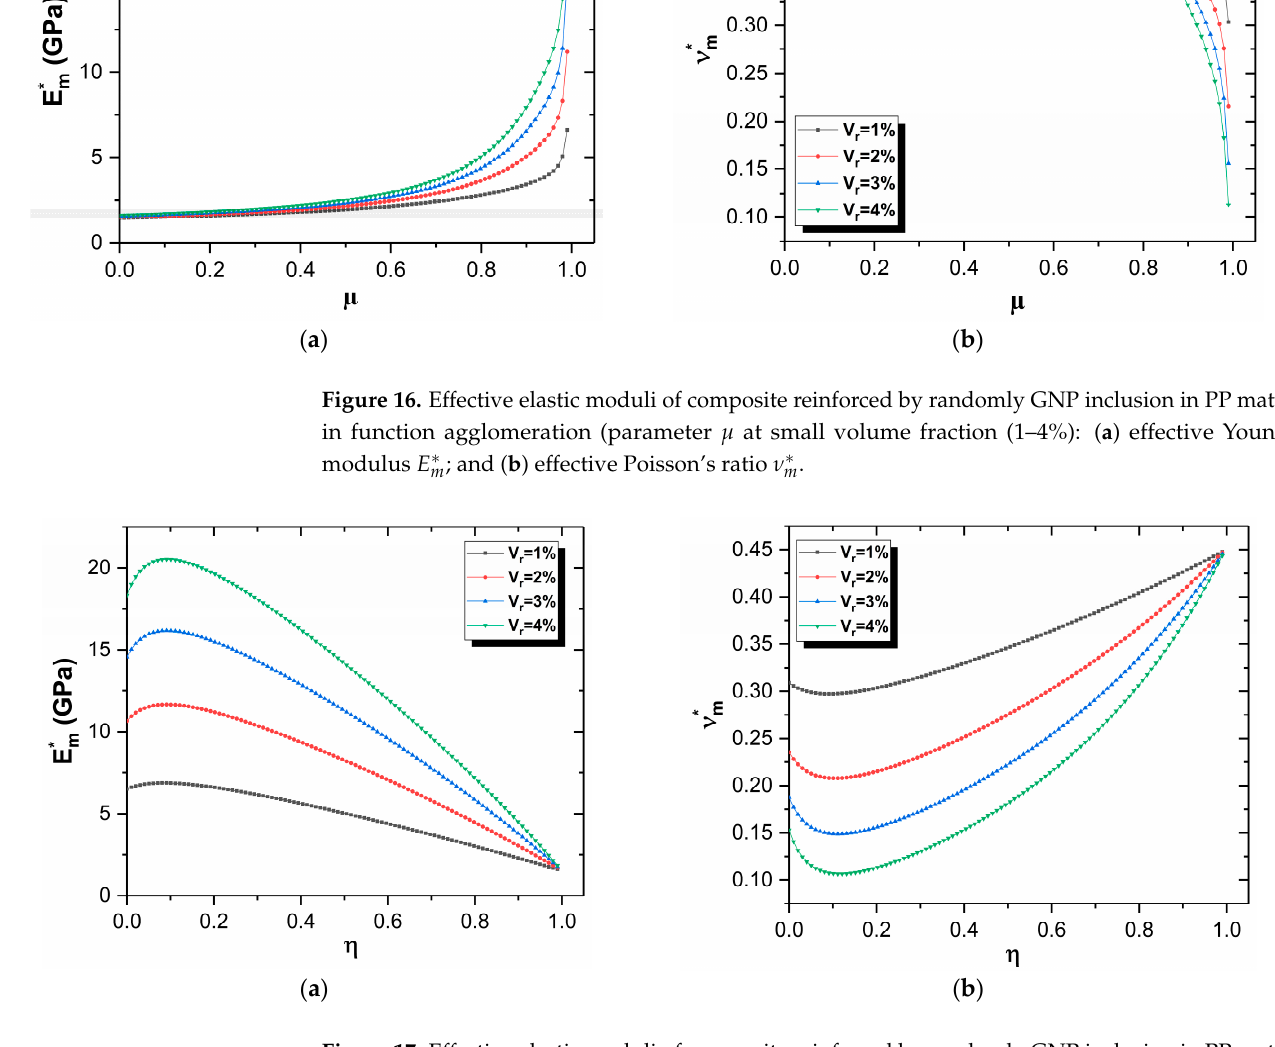
Figure 18. Effective elastic moduli of composite reinforced by randomly GNP inclusion in PP matrix, in function of 𝜂 for 𝜇 = 0.35 with a maximum of Young’s modulus 𝐸 (cid:3040)∗ and minimum of Poisson ratio 𝜈 (cid:3040) ∗ : ( a ) effective Young’s modulus 𝐸 (cid:3040) ∗ ; and ( b ) effective Poisson’s ratio 𝜈 (cid:3040) ∗ . 6. Conclusions In this paper, we studied the elastic behavior of a biocomposite based on Alfa fibers and CNT/GNP-reinforced polymer compared with synthetic fibers used in the wind en- ergy field. As the elastic behavior is characterized by the Young’s modulus and Poisson’s ratio, we evaluated those two properties using analytical and numerical approaches, and also investigated the effect of the volume fraction, aspect ratio, and agglomeration of the inclusions. The key conclusions of this work can be summarized as follows: Computational and numerical approaches show a good agreement for small volume fraction up to 10%; Due its shape, the CNT-reinforced composite has better overall properties in the axial direction and the GNP-reinforced composite has better properties in the transversal direc- tion. The effect of the aspect ratio was also studied, and by increasing the aspect ratio from 1 t 0.0001, the elastic modulus increases for the GNP and reaches a maximum of 260 GPa.